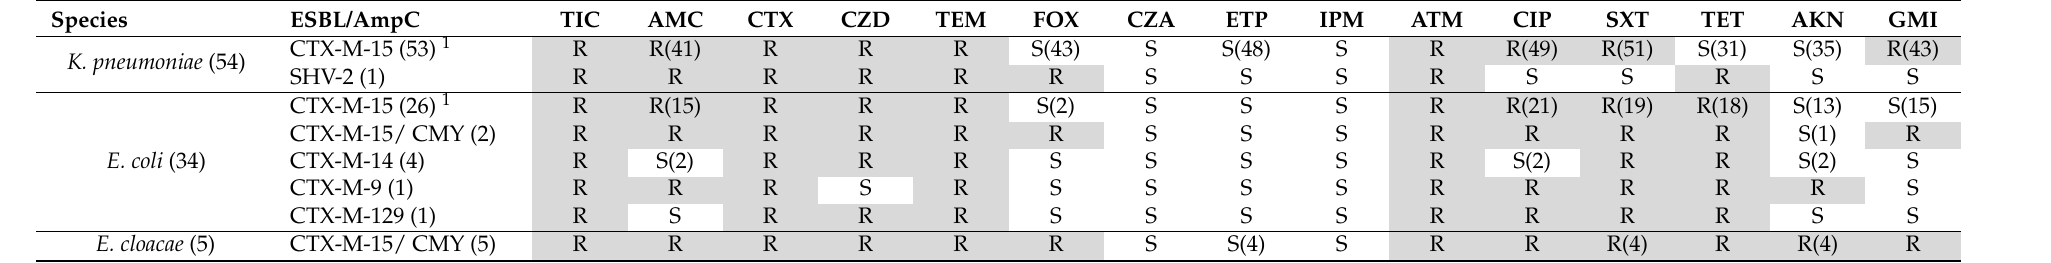
Table 3. Characteristics of the 93 ESBL-producing isolates.